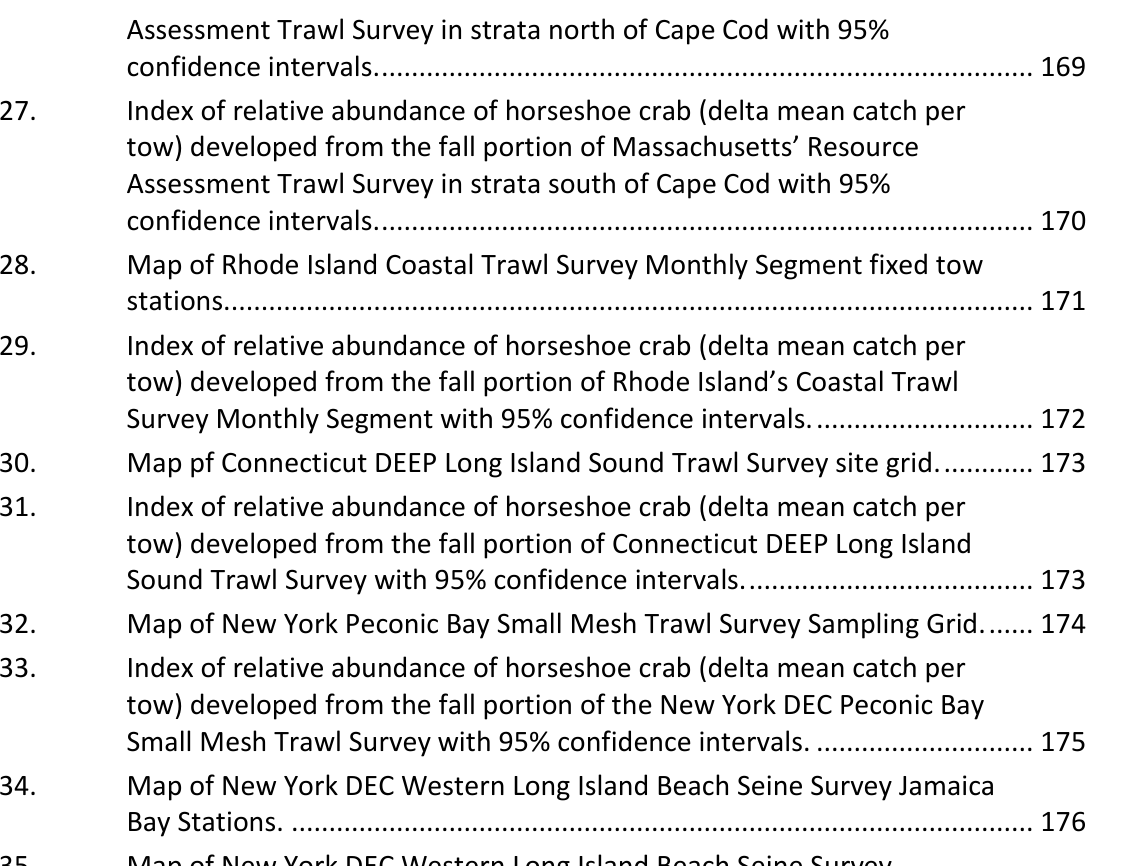
Assessment Trawl Survey in strata north of Cape Cod with 95% Figure 27. Index of relative abundance of horseshoe crab (delta mean catch per tow) developed from the fall portion of Massachusetts’ Resource Assessment Trawl Survey in strata south of Cape Cod with 95% Figure 28. Map of Rhode Island Coastal Trawl Survey Monthly Segment fixed tow Figure 29. Index of relative abundance of horseshoe crab (delta mean catch per tow) developed from the fall portion of Rhode Island’s Coastal Trawl Figure 30. Figure 31. Index of relative abundance of horseshoe crab (delta mean catch per tow) developed from the fall portion of Connecticut DEEP Long Island Figure 32. Figure 33. Index of relative abundance of horseshoe crab (delta mean catch per tow) developed from the fall portion of the New York DEC Peconic Bay Figure 34. Map of New York DEC Western Long Island Beach Seine Survey Jamaica Figure 35. Map of New York DEC Western Long Island Beach Seine Survey Figure 36. Map of New York DEC Western Long Island Beach Seine Survey Little Figure 37. Index of relative abundance of horseshoe crab (delta mean catch per tow) in Jamaica Bay developed from the spring portion of the New York Figure 38. Index of relative abundance of horseshoe crab (delta mean catch per tow) in Manhassett and Little Neck Bays developed from the spring portion of the New York Seine Survey with 95% confidence intervals. ......... 179 Figure 39. Map of the sampling strata used in the NEAMAP survey (map provided by NEAMAP and available on the website http://www.neamap.net/index.html. ............................................................ 180 Figure 40. Index of relative abundance of horseshoe crab (delta mean catch per tow) developed from the fall portion of NEAMAP for the New York region Figure 41. Index of relative abundance of horseshoe crab (delta mean catch per tow) developed from the fall portion of NEAMAP for the Delaware